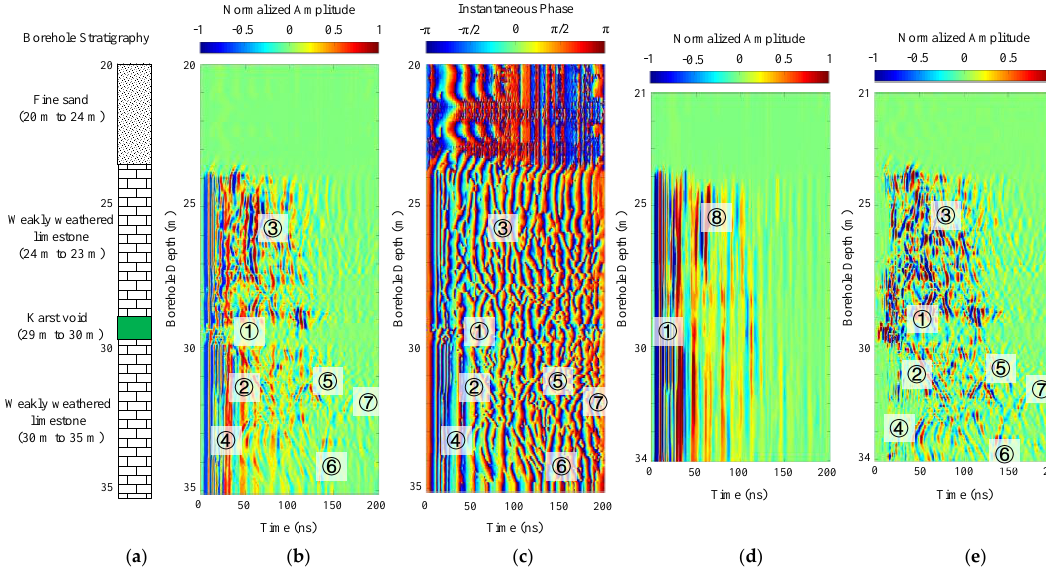
Figure 6. Single borehole GPR detection data for a typical karst void borehole scenario. ( a ) No. ZK-4-11 borehole stratigraphy; ( b ) radar data; ( c ) instantaneous phase; ( d ) removed wave profile using median filtering; ( e ) median filtered wave.